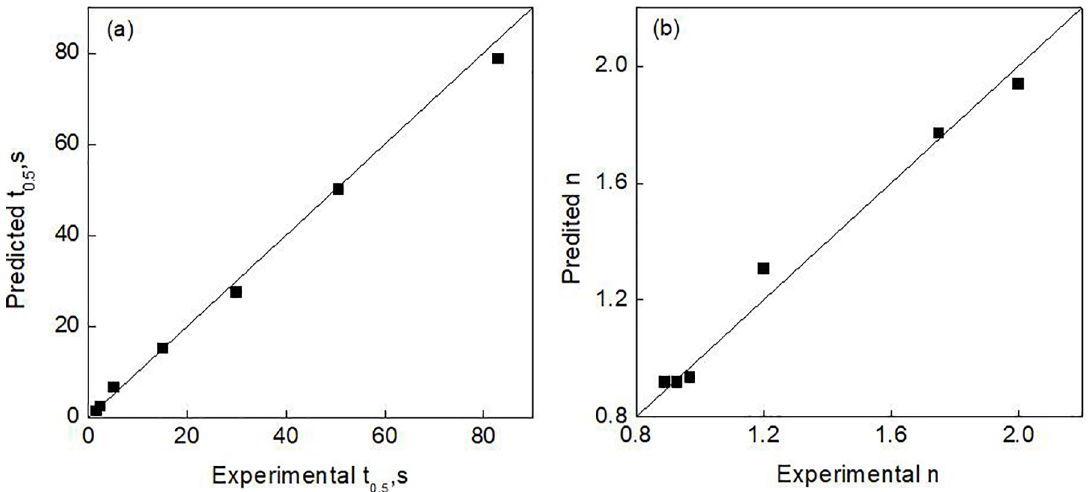
and n with those of experiment. Figure 6. Comparison of the predited value t 0.5 Fig. 5 shows the relationship of k with the initial grain size and annealing temperature. The parameters in Eq.(5) can be calculated by using the same method as dealing with the parameters in Eq.(3) by the value in Table 1 and The calculated results are B = 7.8 × 10 3 , f = -0.70 and Q k = -47.5 kJ/mol